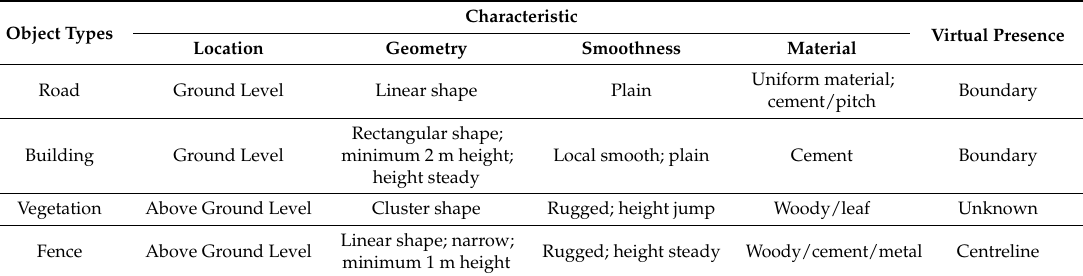
Table 2. Characteristic of target objects.